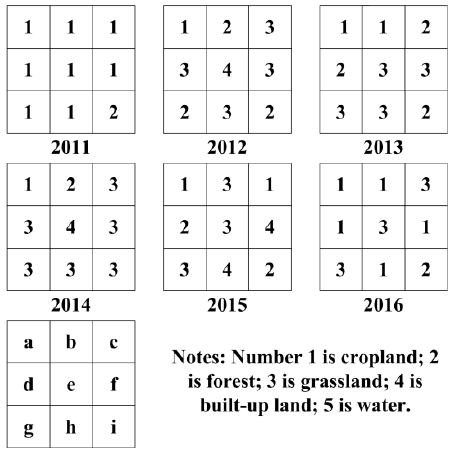
Figure 4. Extraction of abandoned croplands with land use trajectory (note: modified from Song [24]).